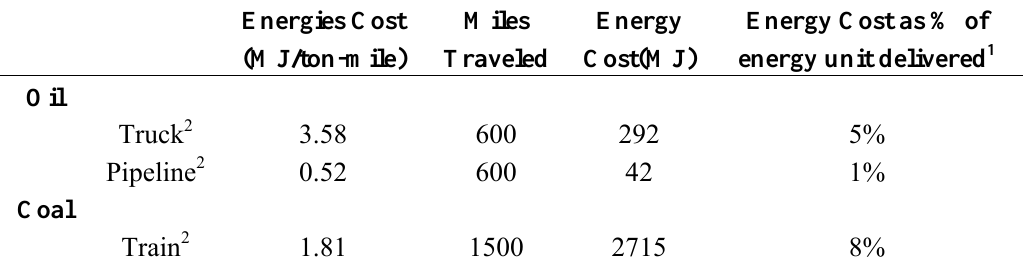
Table 1. The energy cost of transporting oil and